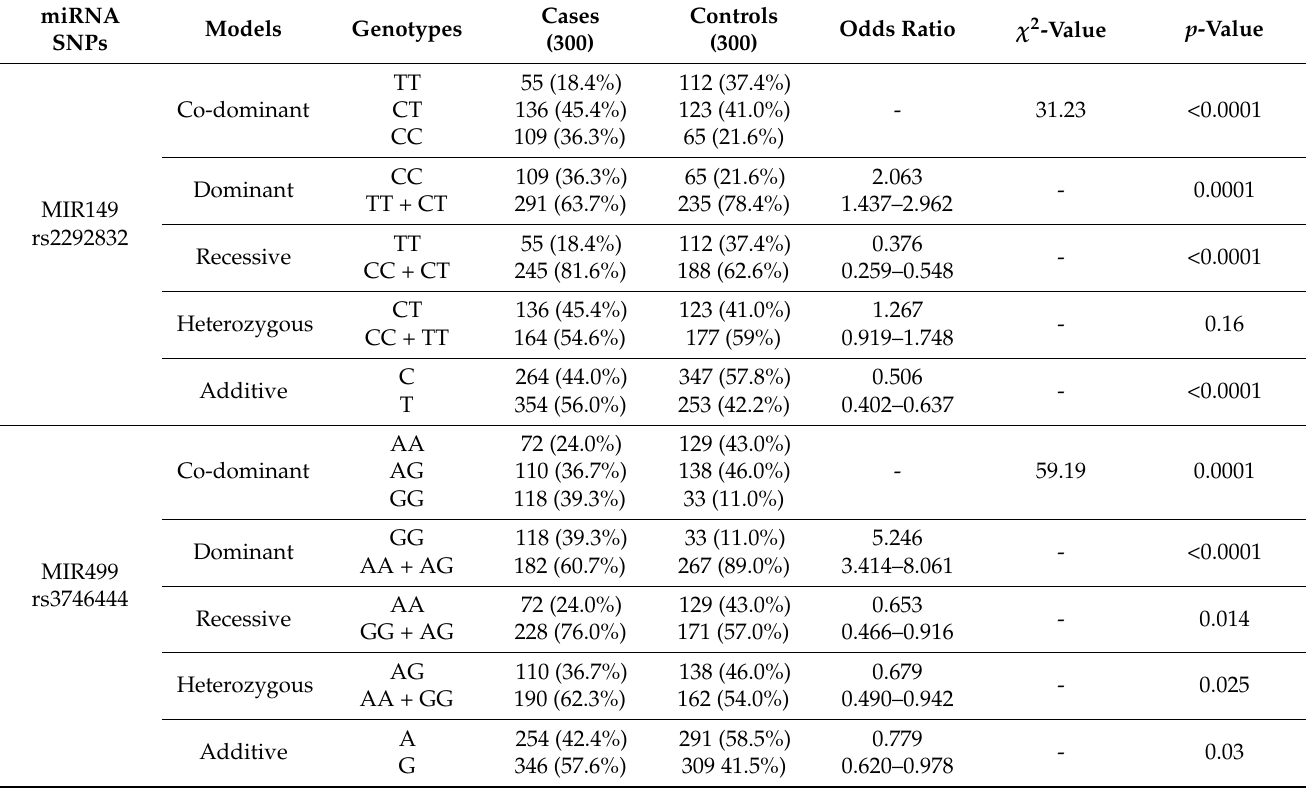
Table 3. Association of RA risk-associated miRNAs in Pakistani case-control